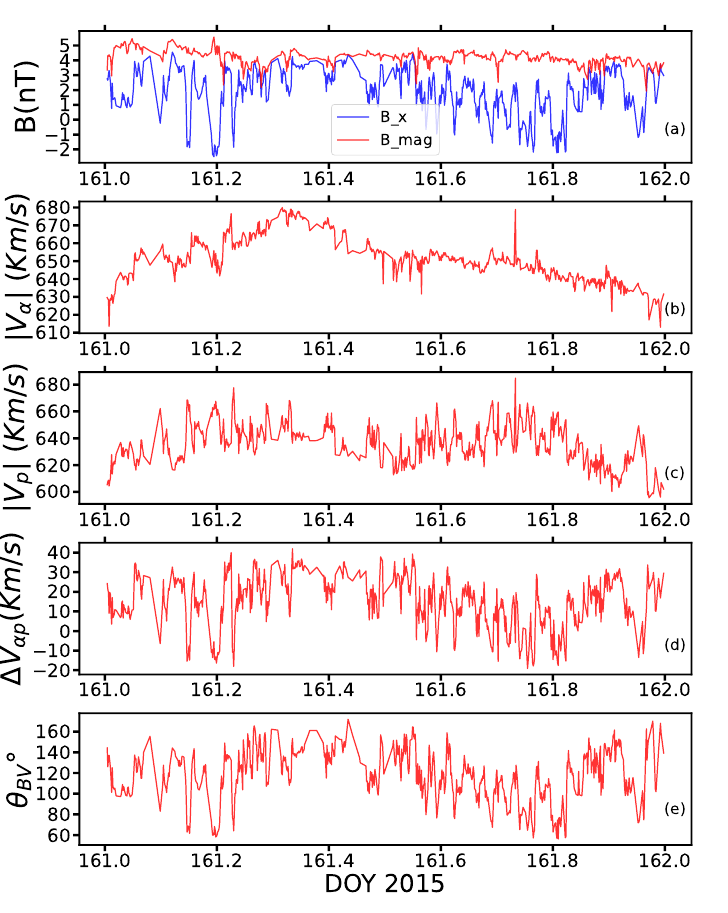
Figure 1. Illustration of typical parameters of a fast wind interval at 1 au using WIND data from 10 June 2015. Panel ( a ) shows the magnitude of the magnetic field and the B X component; Panel ( b ) shows the alpha bulk speed; Panel ( c ) shows the proton bulk speed; Panel ( d ) shows the difference between the alpha and proton bulk speed; and Panel ( e ) shows the angle between the B and V